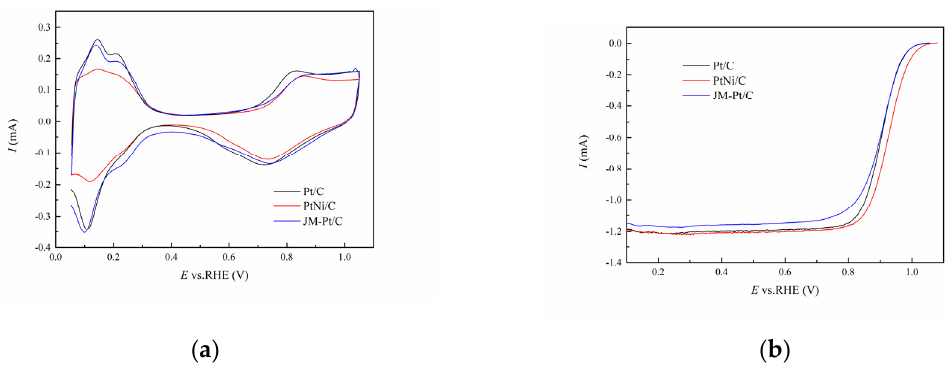
Figure 5. CV ( a ) and LSV( b ) curves of PtNi/C, JM-Pt/C, and Pt/C. Table 3. ECSA and MA parameters of PtNi/C Pt/C, and JM-Pt/C catalysts.